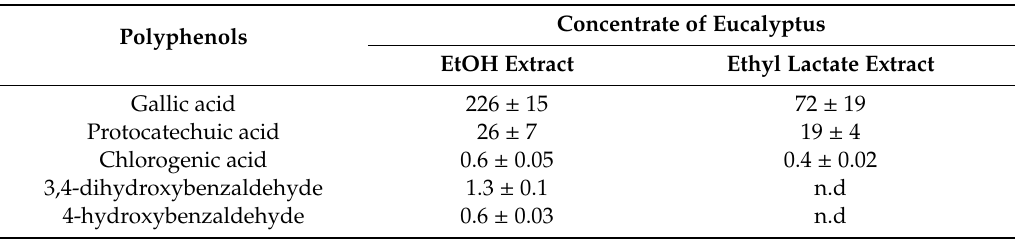
Table 5. Concentration of polyphenols (mg L − 1 ) in the organic extracts derived from the concentrate of Eucalyptus. LC-MS / MS